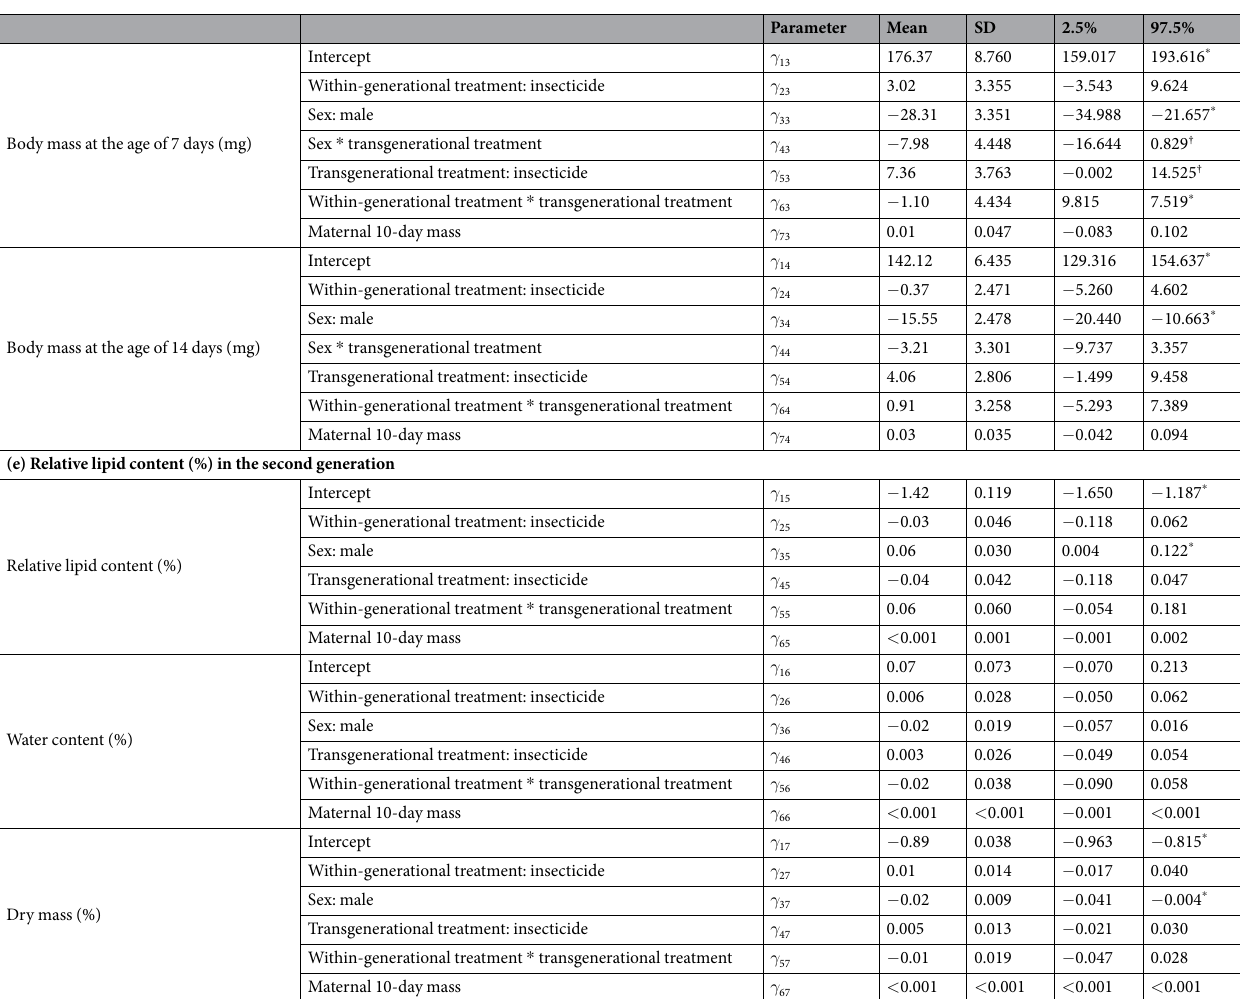
Table 1. Posterior means, standard deviations (i.e. SD) and 95% credible intervals for all the measured traits, and how they contribute to (a) survival in the first generation, (b) development time and body mass in the first generation, (c) survival in the second generation, (d) development time and body mass in the second generation, and (e) relative lipid content (%) in the second generation. Parameters with posterior probabilities greater than 95% are marked with * , and those with moderate effects are marked with †